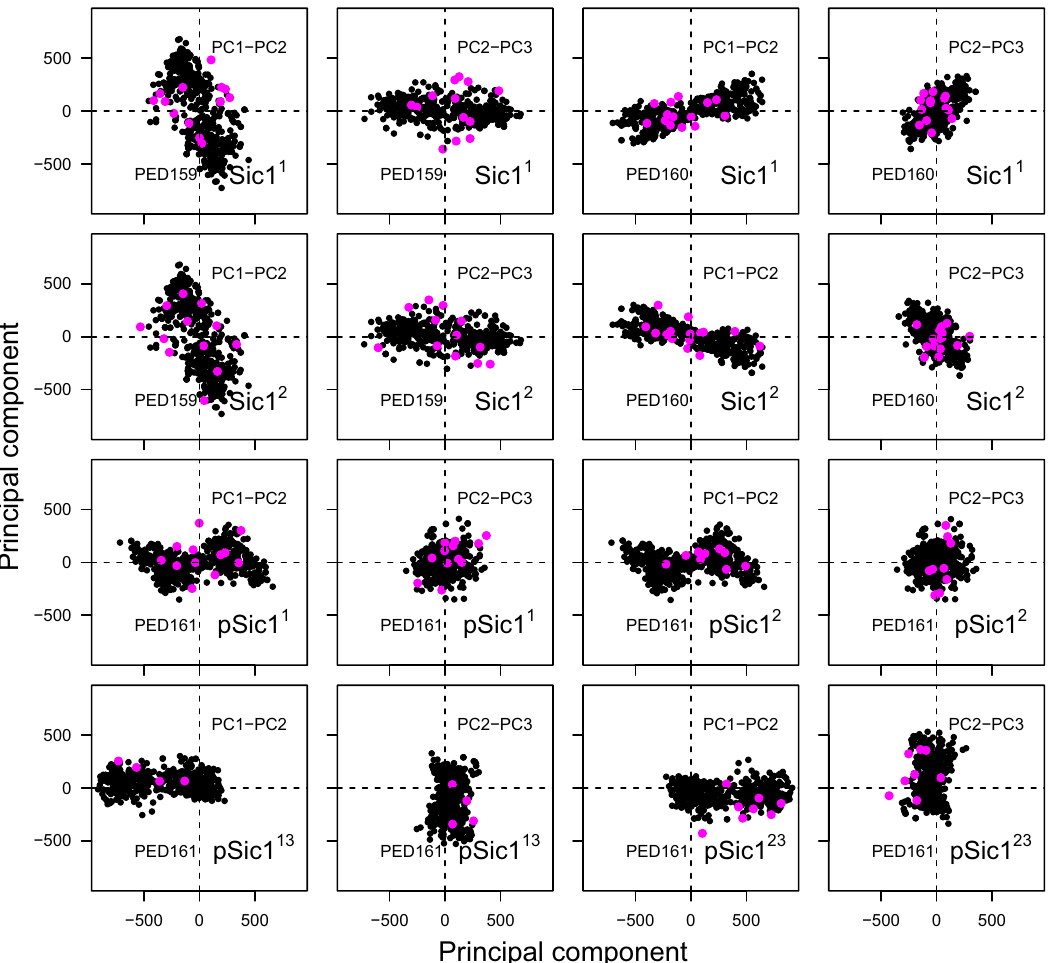
Figure 6. Projections of the Sic1 and pSic1 conformations along the three largest components of their principal component analysis (PCA). On these projections, the TAiBP conformations selected by BioEn or RamaMix are colored in magenta and the conformations stored in PED 21 are colored in